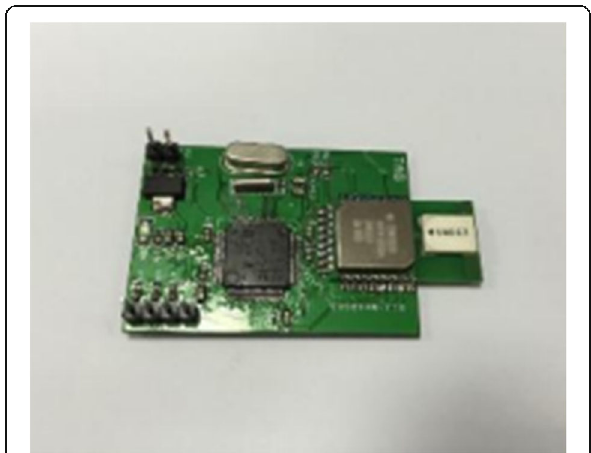
Fig. 6 The tag. The tag adopts the STM32103RC chip as the control